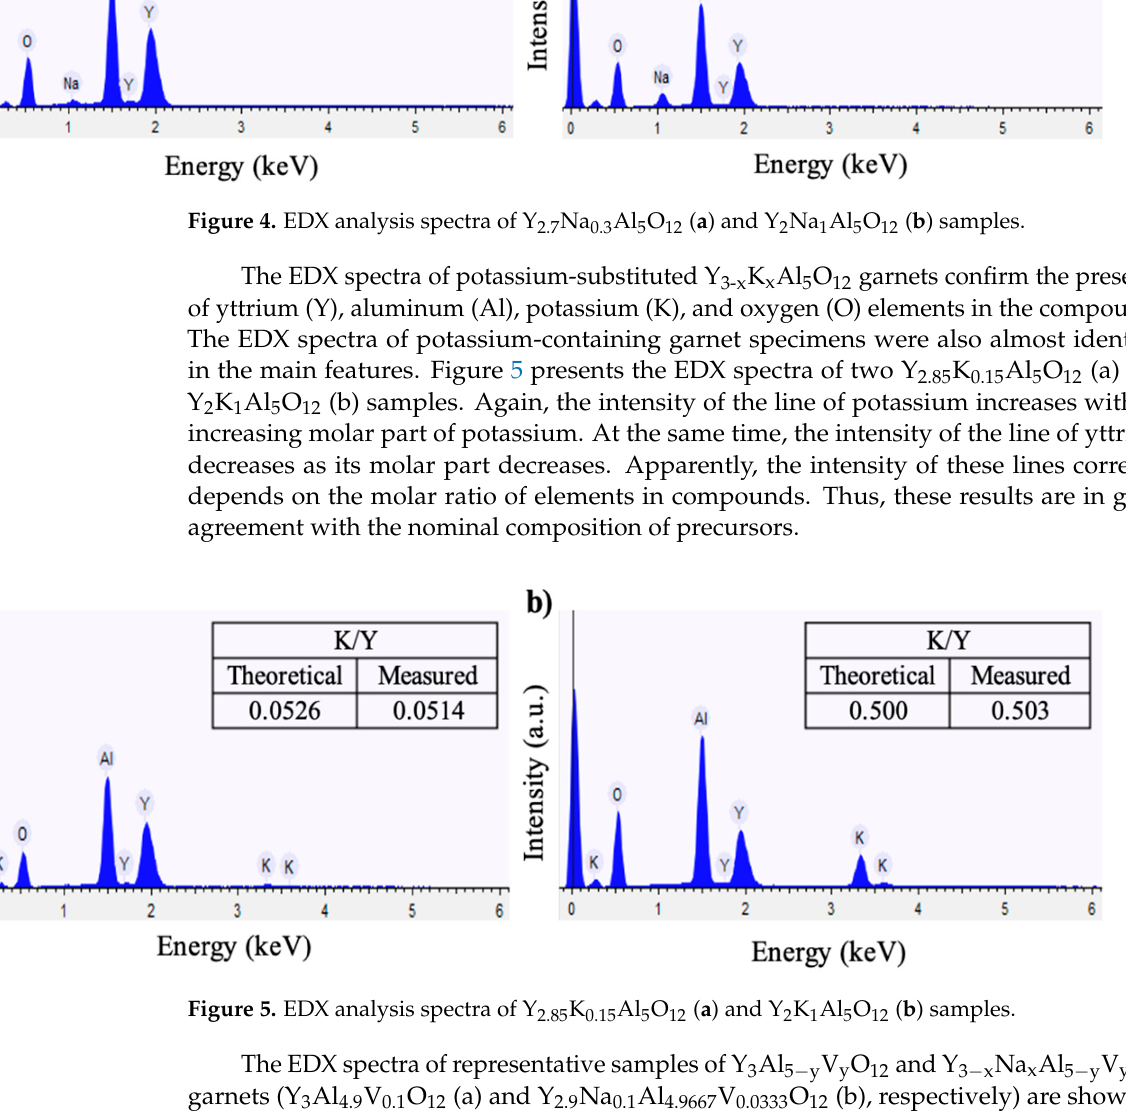
Figure 6. All EDX spectra of Y 3 Al 5 − y V y O 12 compounds contain characteristic lines of